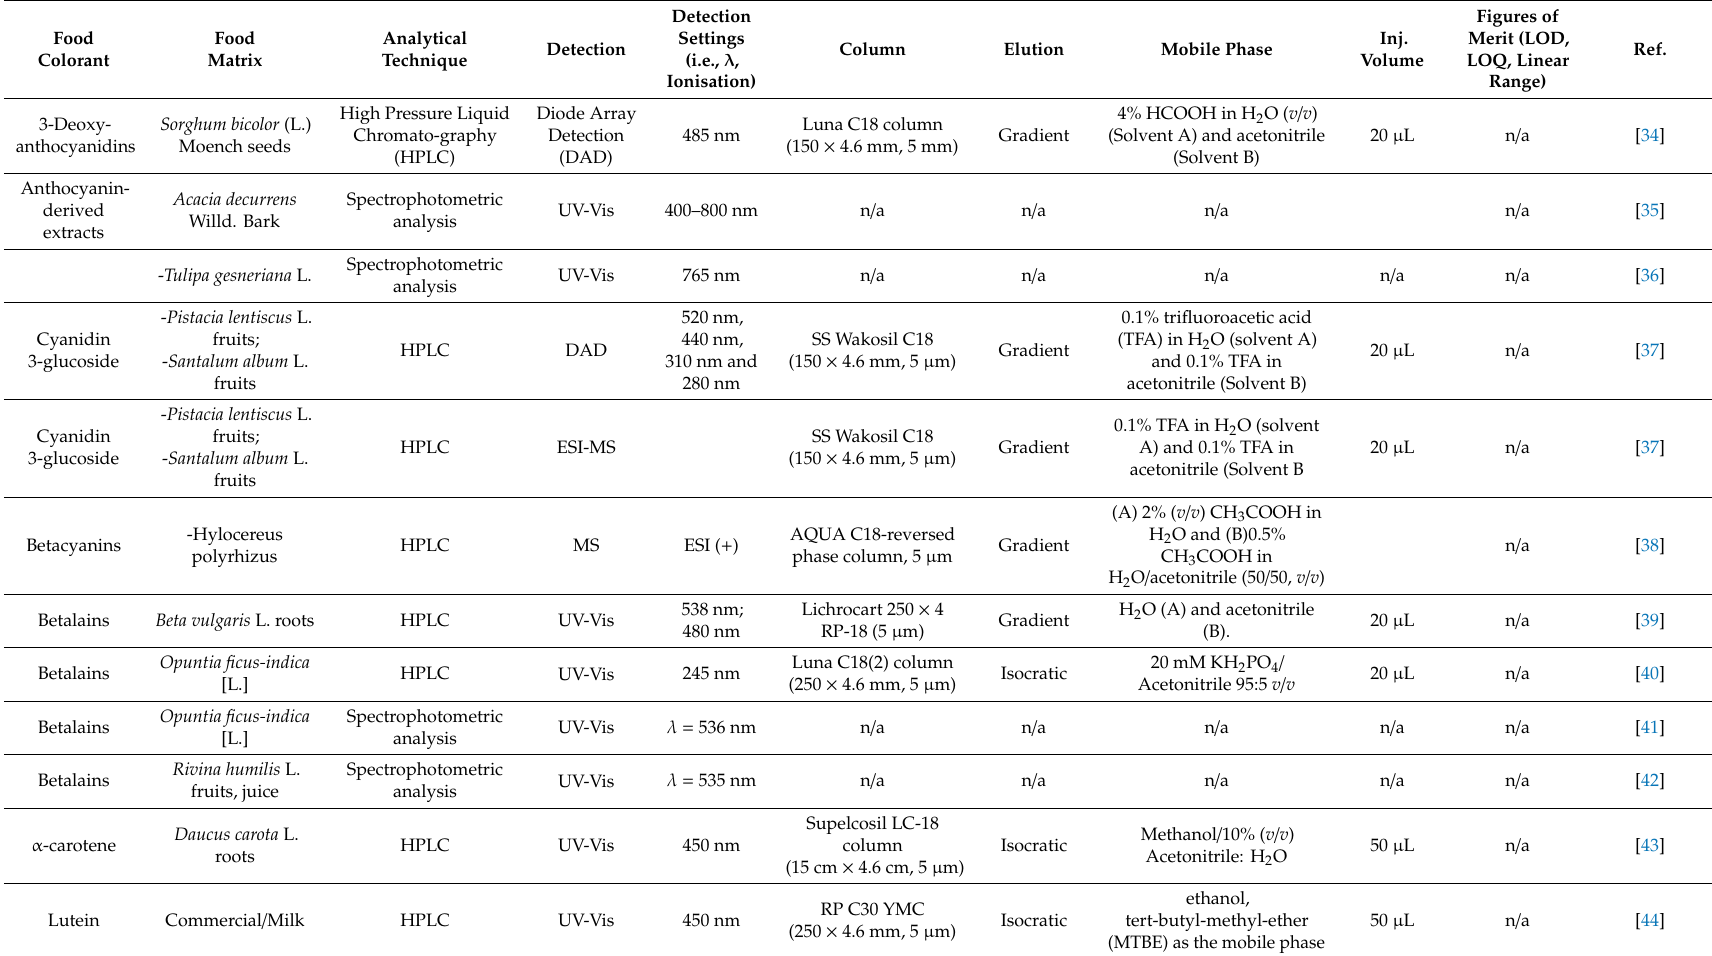
Table 1. Methods for the analysis of natural food colorants in various food